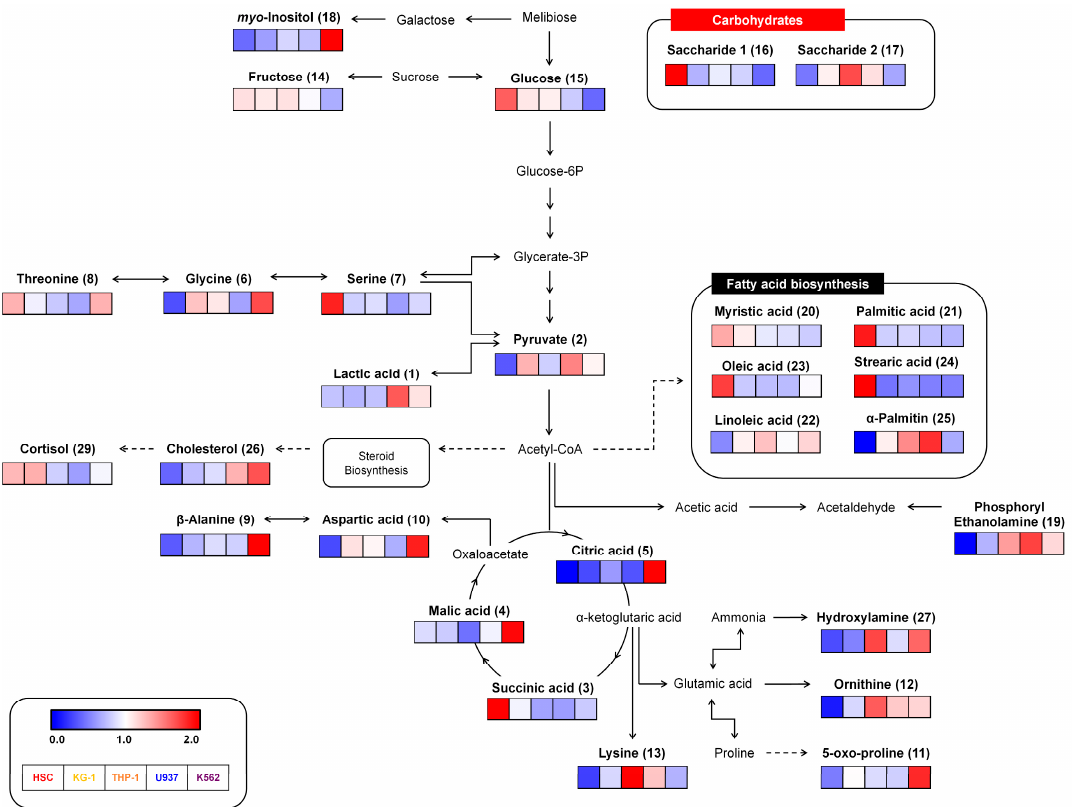
Figure 3. Constructed metabolic pathway showing relative metabolite contents for four different leukemia cell lines and a normal hematopoietic stem cell (HSC) line. The pathway was modified from the Kyoto Encyclopedia of Genes and Genomes (KEGG) database (http://www.genome.jp/kegg/). The colored squares (blue-to-red) represent relative metabolite abundance in the five cell lines.